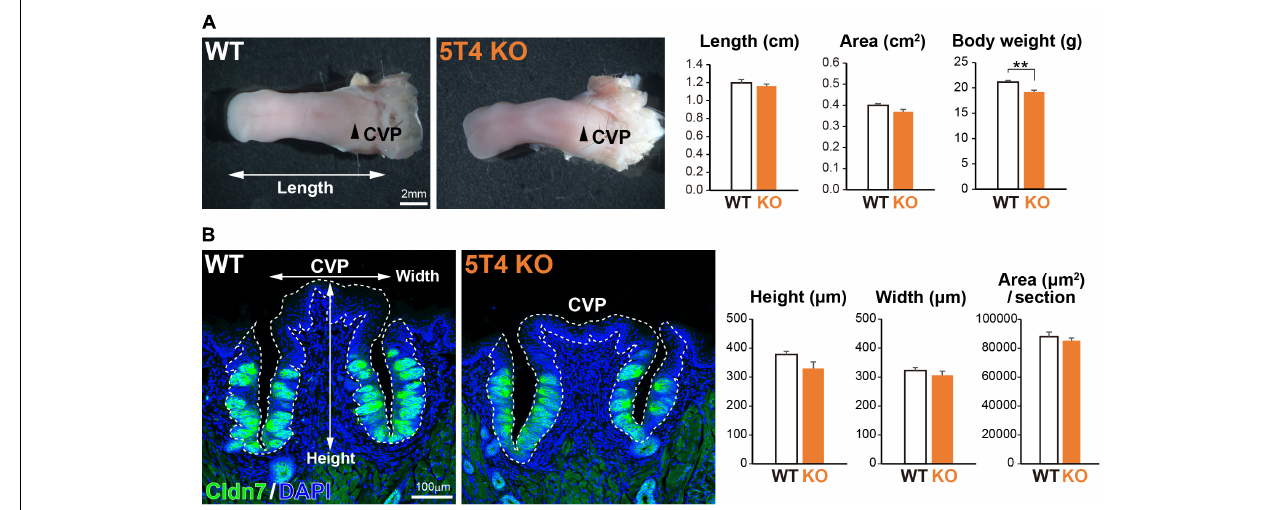
FIGURE 3 | Loss of 5T4 function does not affect the size of the CVP. ( A , Left) Photographs of tongues prepared from 6-week-old WT and 5T4- KO mice. CVPs are indicated by arrowheads. Scale bars, 2 mm. (Right) Body weights of 6-week-old WT and 5T4- KO mice are expressed as the mean ± SEM ( ∗∗ p < 0.01, Student’s t test; n = 6 WT mice and n = 5 5T4 -KO mice). The lengths and areas of tongues prepared from 6-week-old WT and 5T4 -KO mice are expressed as the mean ± SEM. The tongue area was defined as that ranging from the tongue tip to the tongue base. ( B , Left) IHC of the CVP from WT and 5T4 -KO mice with an anti-Cldn7 antibody (a marker of TBCs; green) and DAPI (blue). Scale bars, 100 µ m. (Right) Average heights, widths, and areas of the CVP are expressed as the mean ± SEM ( n = 6 sections per bar from three mice). Images represent Z-stack projections of three sections (2.20 µ